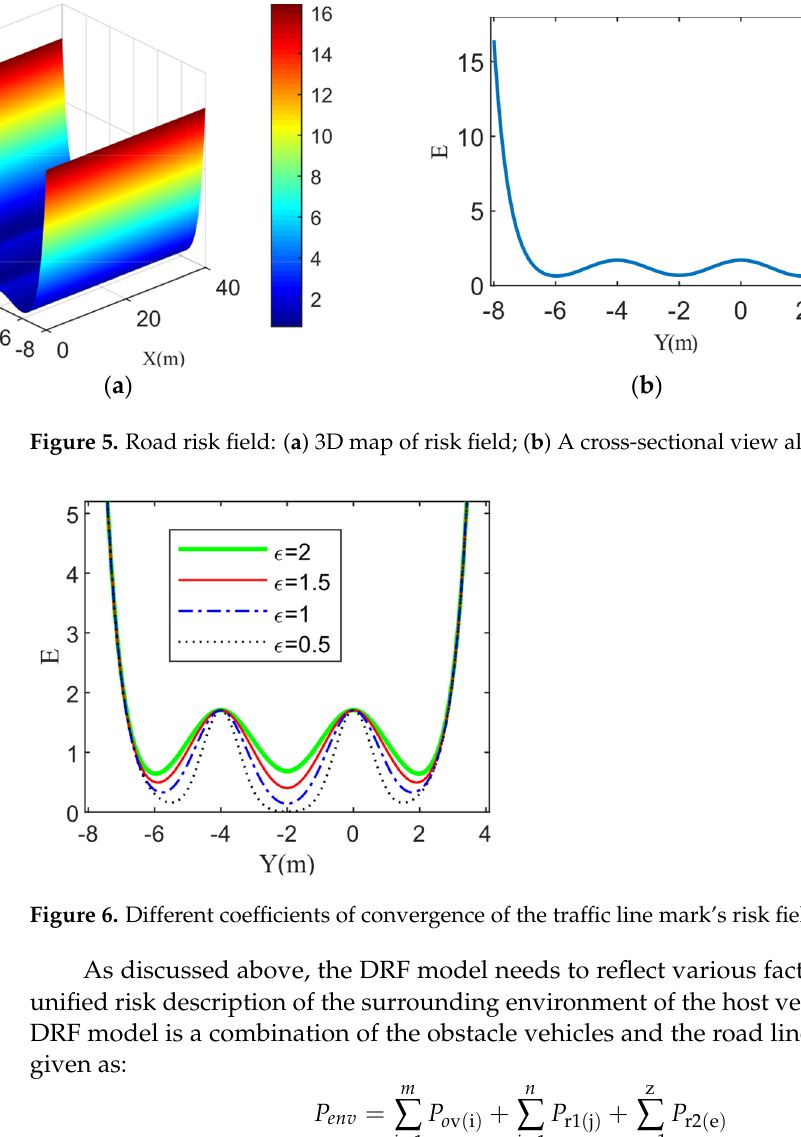
Figure 7. Contour distribution of HV’s driving risk field in the example scenario. 4.3. DRF-Based MPC Controller MPC is used in this paper to predict the motion state of HV for multiple steps in the future. The DRF strength of the predicted states of MPC is taken into account as a critical component of the MPC cost function to perform trajectory planning and motion control synchronously. The field strength of the HV’s kth prediction step is defined as follows: ( )